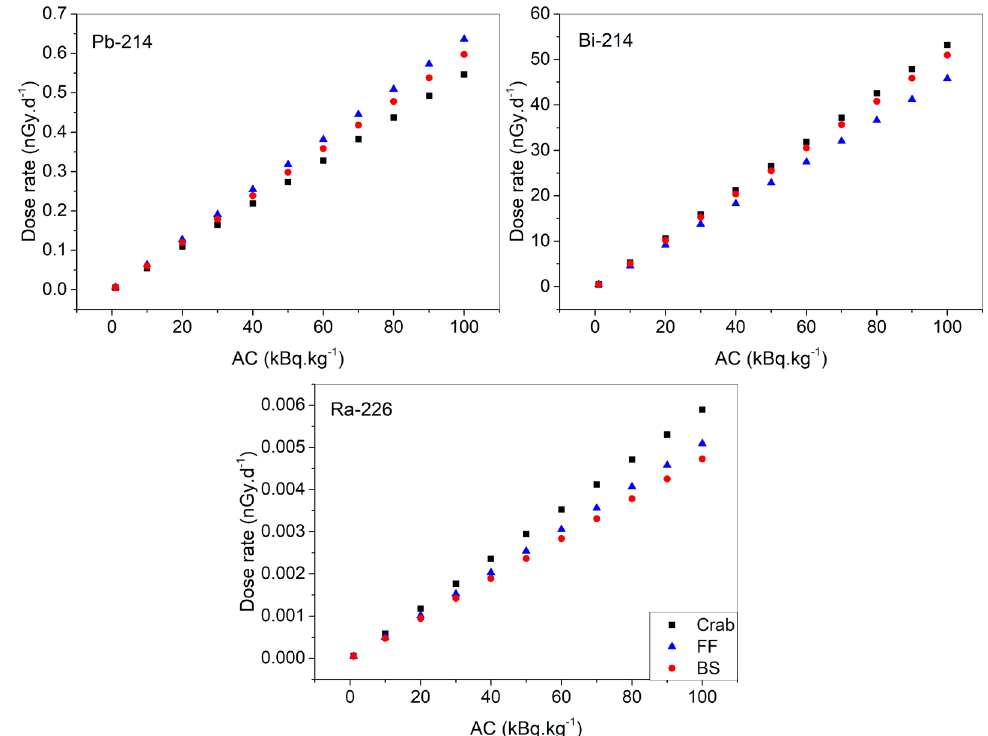
Figure 3. D ’s contribution due to the uranium series for each organism. R